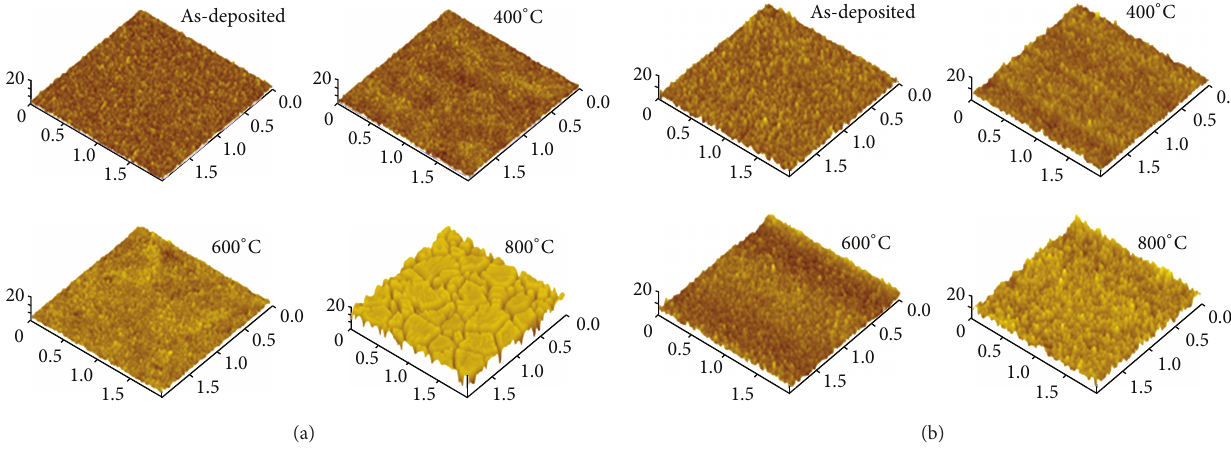
Figure 6: Surface morphology (2 × 2 𝜇 m) by AFM of TiO 2 films from (a) Ti 3 O 5 and (b) TiO 2 starting materials annealed at 400 ∘ C, 600 ∘ C, and 800 ∘